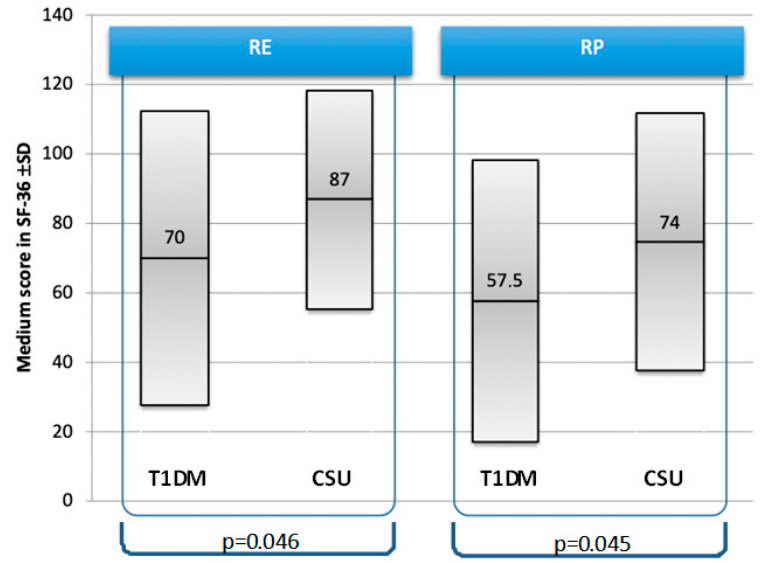
Figure 2. Impairment in the quality of life (QoL) of married patients with type 1 diabetes mellitus (T1DM) and chronic spontaneous urticaria (CSU), referring to SF-36 “role limitations due to emotional problems” (RE) and “role limitations due to physical problems” (RP).